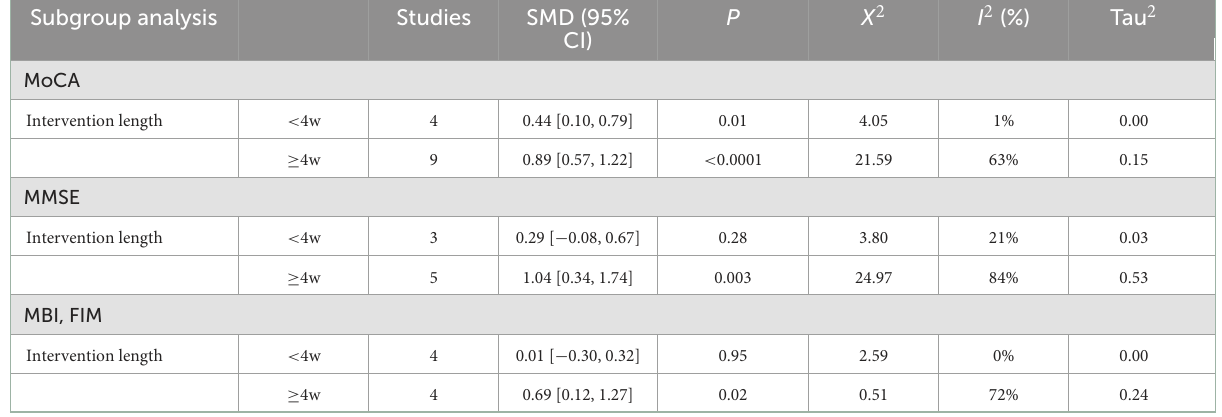
TABLE 3 Subgroup analysis of NIBS on PSCI patients. Subgroup